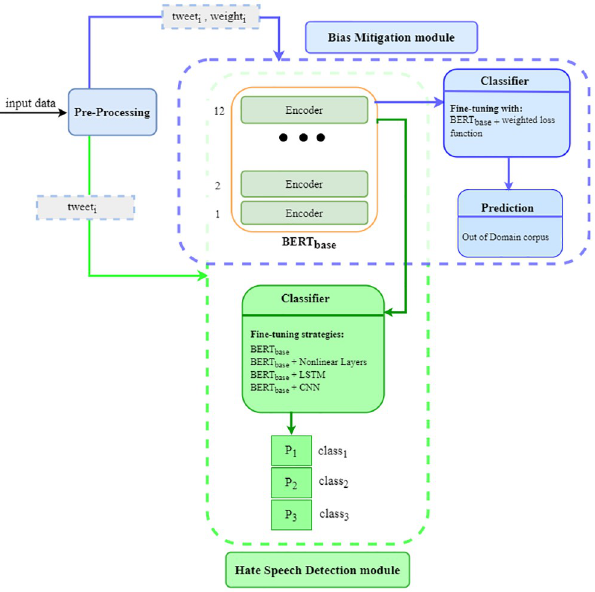
Fig 1. The proposed framework for hate speech detection and bias mitigation tasks. It consists of two different modules: Hate Speech Detection and Bias Mitigation with different inputs as a result of different pre-processing approaches. The pre-trained BERT base is a common component between two modules that is fine-tuned differently in respect of each module’s goal.